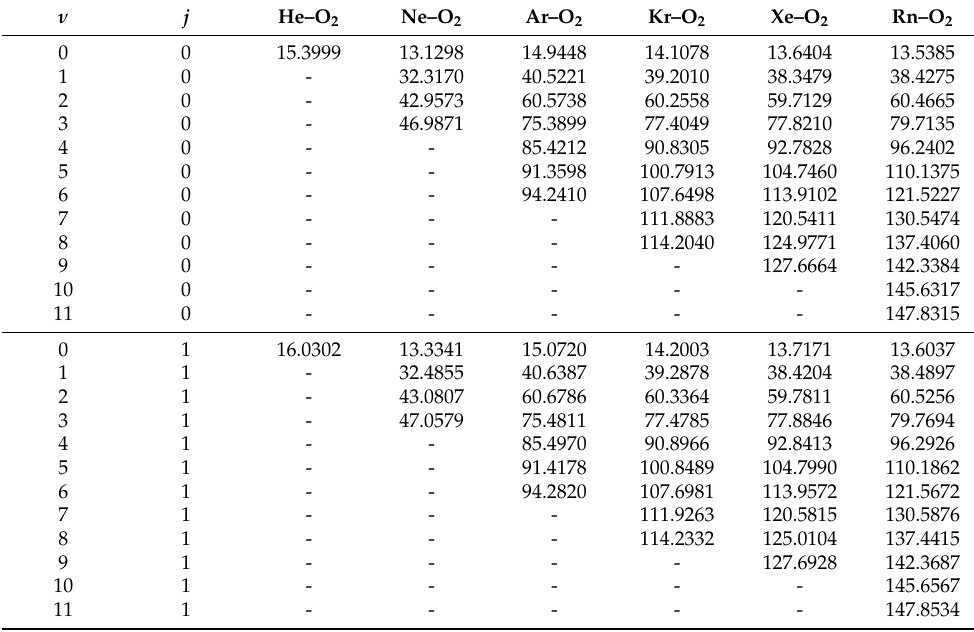
Table 3. Vibrational ( j = 0) and rovibrational ( j = 1) energies in cm − 1 for the Ng–O 2 complexes obtained through the ECF potential energy curve.